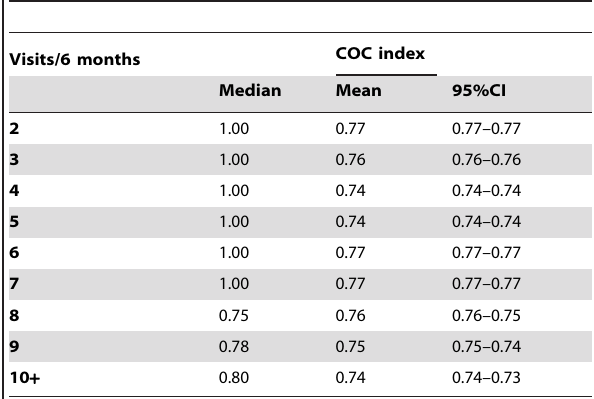
Table 2. COC index according to number of visits to a